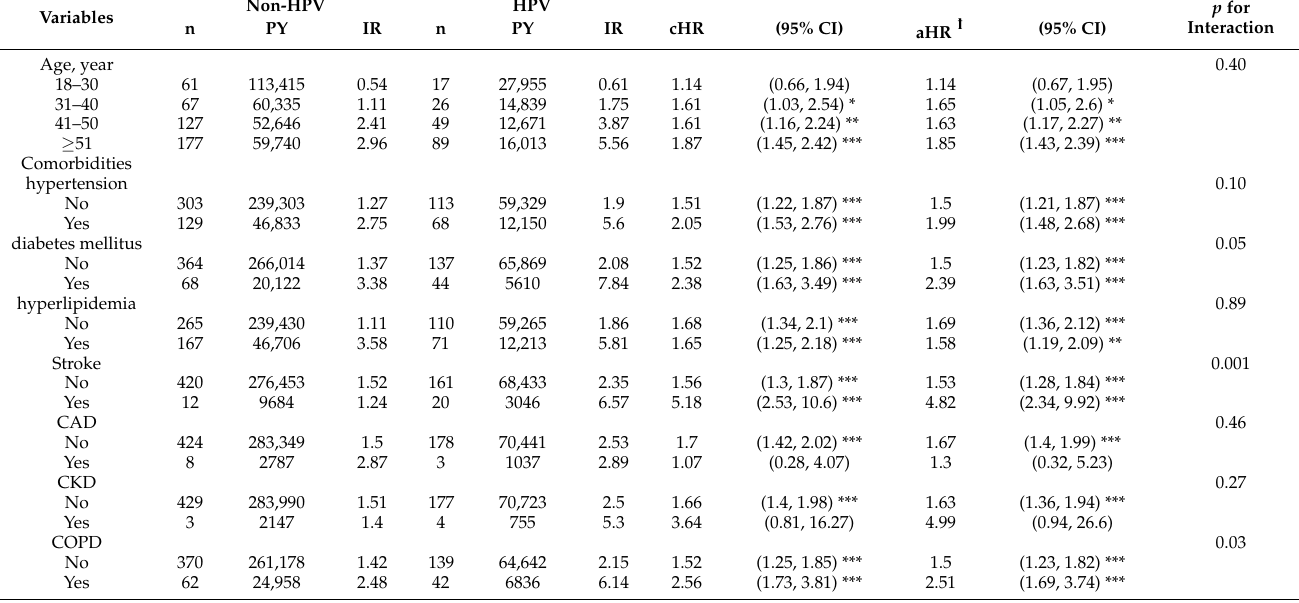
Table 4. Subgroup analyses for the effect of HPV infection on ED risks under different stratification. Table 3. The association of explanatory variables and the risk of erectile